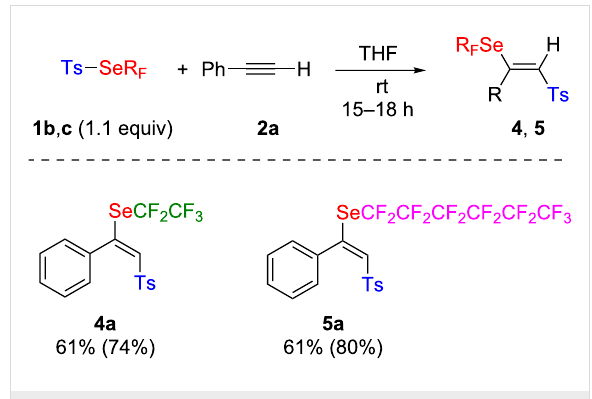
Figure 1: Single-crystal X-ray structure of 3a .